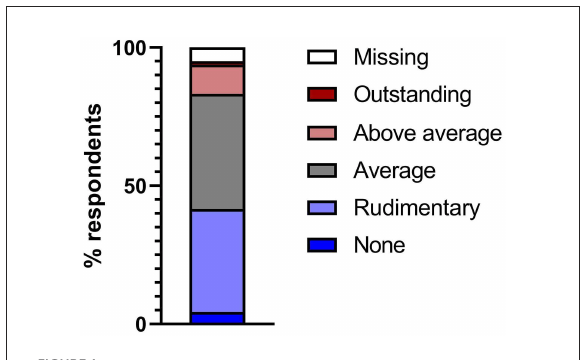
FIGURE1 Self-reported knowledge of artificial intelligence and its application, relative to peers in that field.